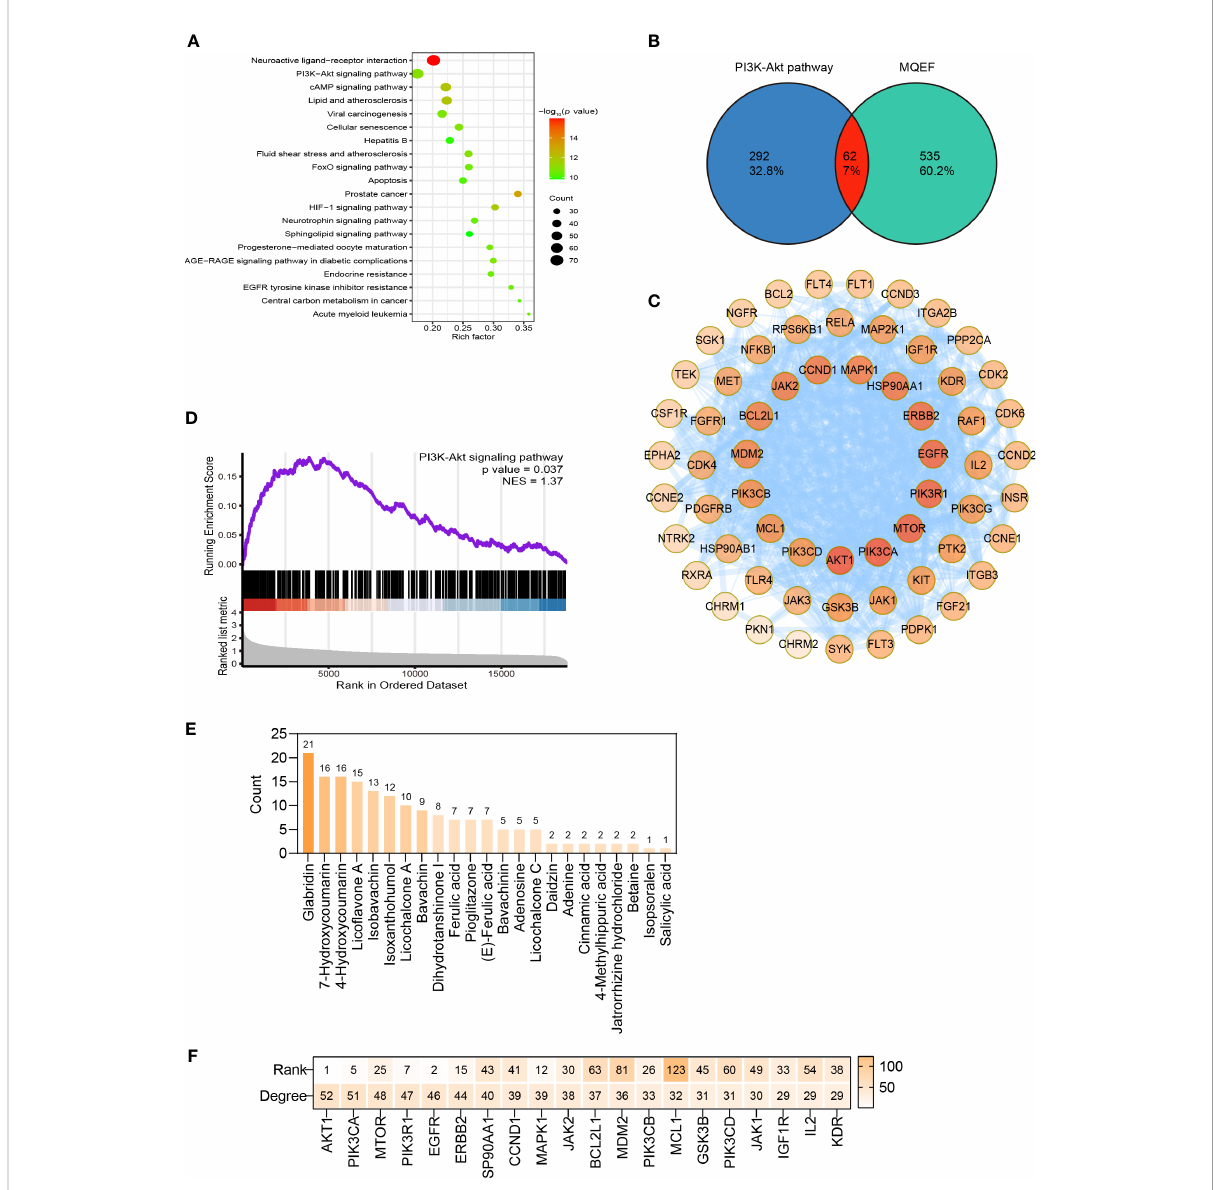
FIGURE 7 Network pharmacology. (A) Top 20 KEGG enrichment pathway for the 597 targets of the 34 active ingredients in MQEF. (B) The intersection of 354 targets in the PI3K-Akt pathway with 597 targets in the MQEF were obtained by drawing Venn diagrams from the R package (Venn Diagram). (C) The 62 key targets for MQEF to exert anti-INFH through the PI3K-Akt signaling pathway. (D) Gene expression pro fi le of the PI3K- Akt signaling pathway found to be signi fi cantly enriched in hormonal femoral necrosis disease by microarray analysis. (E) Degree of the role of the 62 targets in the PI3K-Akt signaling pathway. (F) The 34 active chemical components of the MQEF were intersected with 62 intersecting targets involved in PI3K-Akt signaling pathway to explore which compounds have more targets to regulate PI3K-Akt signaling pathway, and fi nally there were 23 active components corresponding to 62 targets involved in the